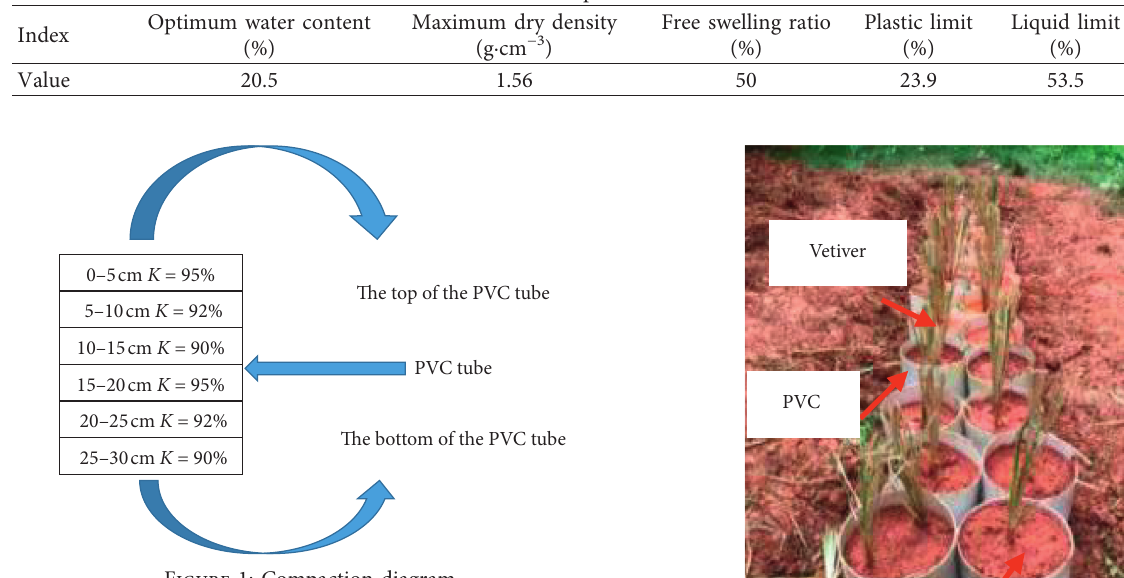
Figure 1: Compaction diagram.